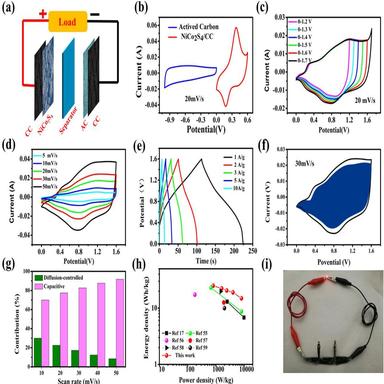
(a) Schematic illustration for the assembled supercapacitors. (b) CV curves of the NiCo2S4/CC and AC/CC at 20 mV s1 . (c) CV curves of NiCo2S4/CC//AC/CC asymmetric supercapacitor obtained at different potential window at a scan rate of 20 mV s1 . (d) CV curves of the ASC at different scan rates between 0 and 1.6 V. (e) Galvanostatic charge/discharge curves of the ASC at different current density. (f) Capacitive contribution (blue) for the ASC at 30 mV s1 . (g) Normalized contribution of capacitive capacitie